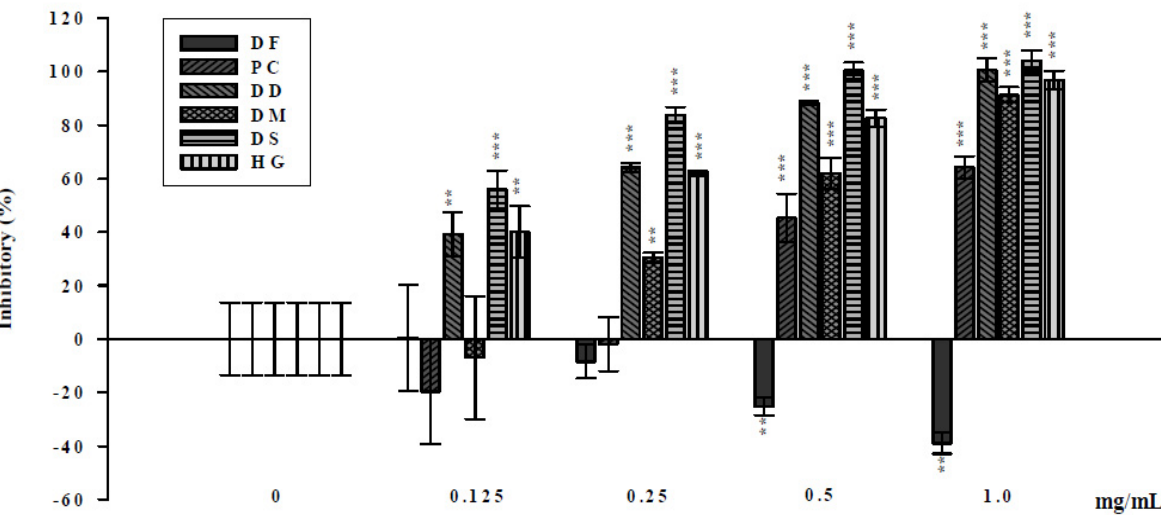
Figure 1. Inhibitory ability of six sources of Gusuibu on the binding of LTB to G competitive G -ELISA. Different quantities of six sources of Gusuibu were incubated with M1 16 ng biotinylated LTB at 4 °C for 3 h. The wells were coated with 200 ng of G challenged with 100 μ L of biotinylated LTB/compound mixture. Following three washes, peroxidase-conjugated avidin and chromatic substrate were sequentially added. The absorbance was read at 405 nm in an ELISA plate reader. The results are expressed as inhibitory ability (%). Values represent mean ± standard error of four independent